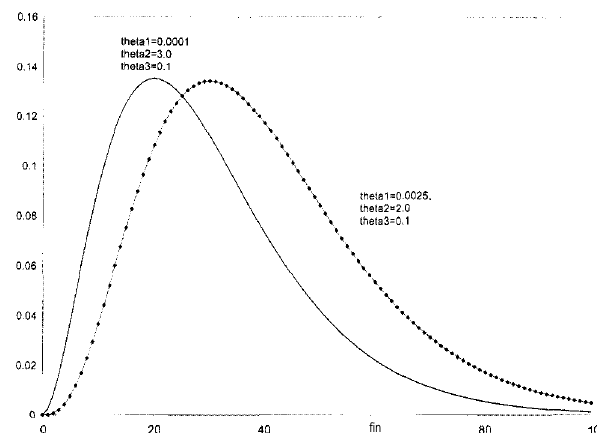
Figuw 1 - Palucs of CO, corrisponding to difierent configurations of O,, 0, m d